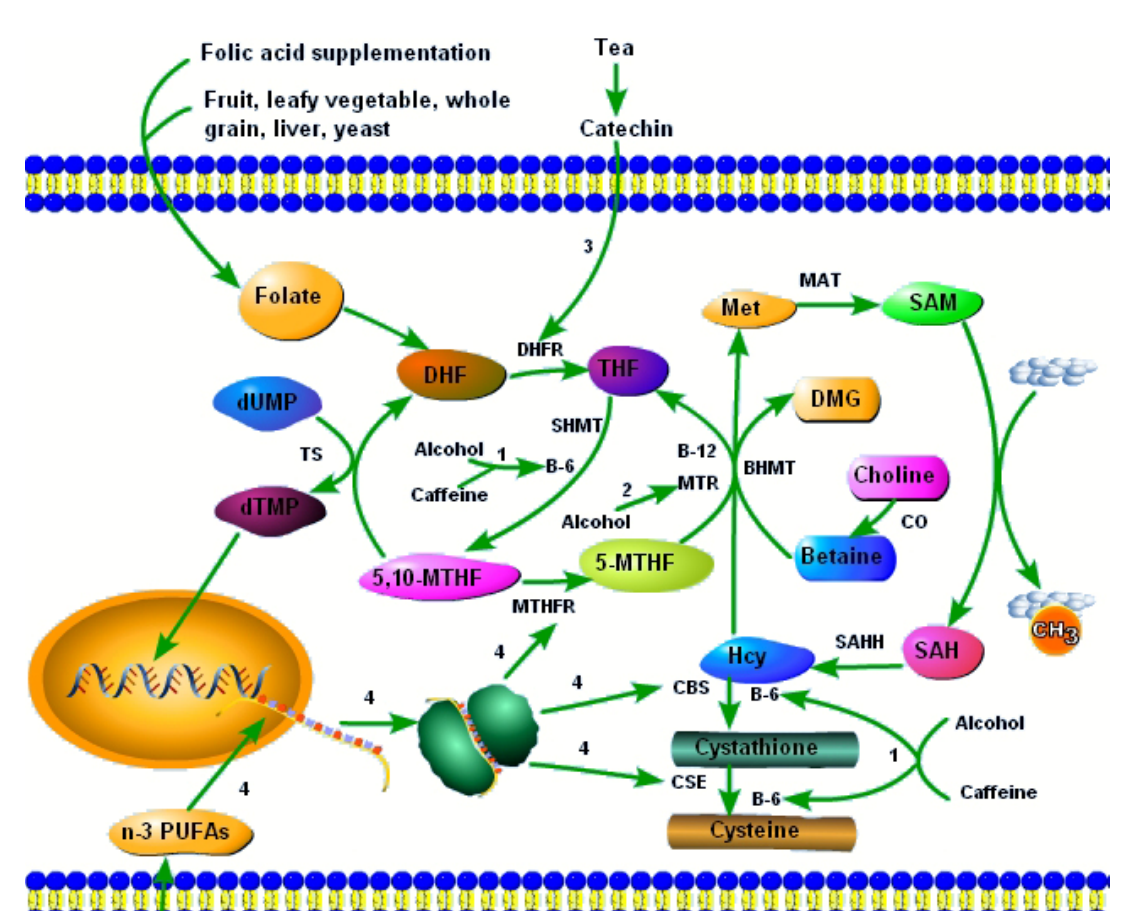
Figure 1. B vitamins and other dietary factors interact with the one-carbon metabolism to influence the development of NTDs. 1, alcohol and caffeine lower vitamin B-6, and thus disturb vitamin B-6–dependent one-carbon metabolism pathways; 2, alcohol reduces the activity of MTR , leading to increased Hcy and reduced SAM; 3, catechins in tea reduce the activity of DHFR , and hinder the synthesis of THF; 4, n -3 PUFAs increase the mRNA expression of enzymes involved in one-carbon metabolism, such as MTHFR , CBS , and CSE . Abbreviations: DHF, dihydrofolate; THF, tetrahydrofolate; 5,10-MTHF, 5,10-methylenetetrahydrofolate; 5-MTHF, 5-methyltetrahydrofolate; dUMP, deoxyuridine monophosphate; dTMP, thymidinemonophosphate; Hcy, homocysteine; Met, methionine; SAM, S-adenosylmethionine; SAH, S-adenosylhomocysteine; DMG, dimethylglycine; DHFR , dihydrofolate reductase; SHMT , serine hydroxymethyltransferase; MTHFR ,